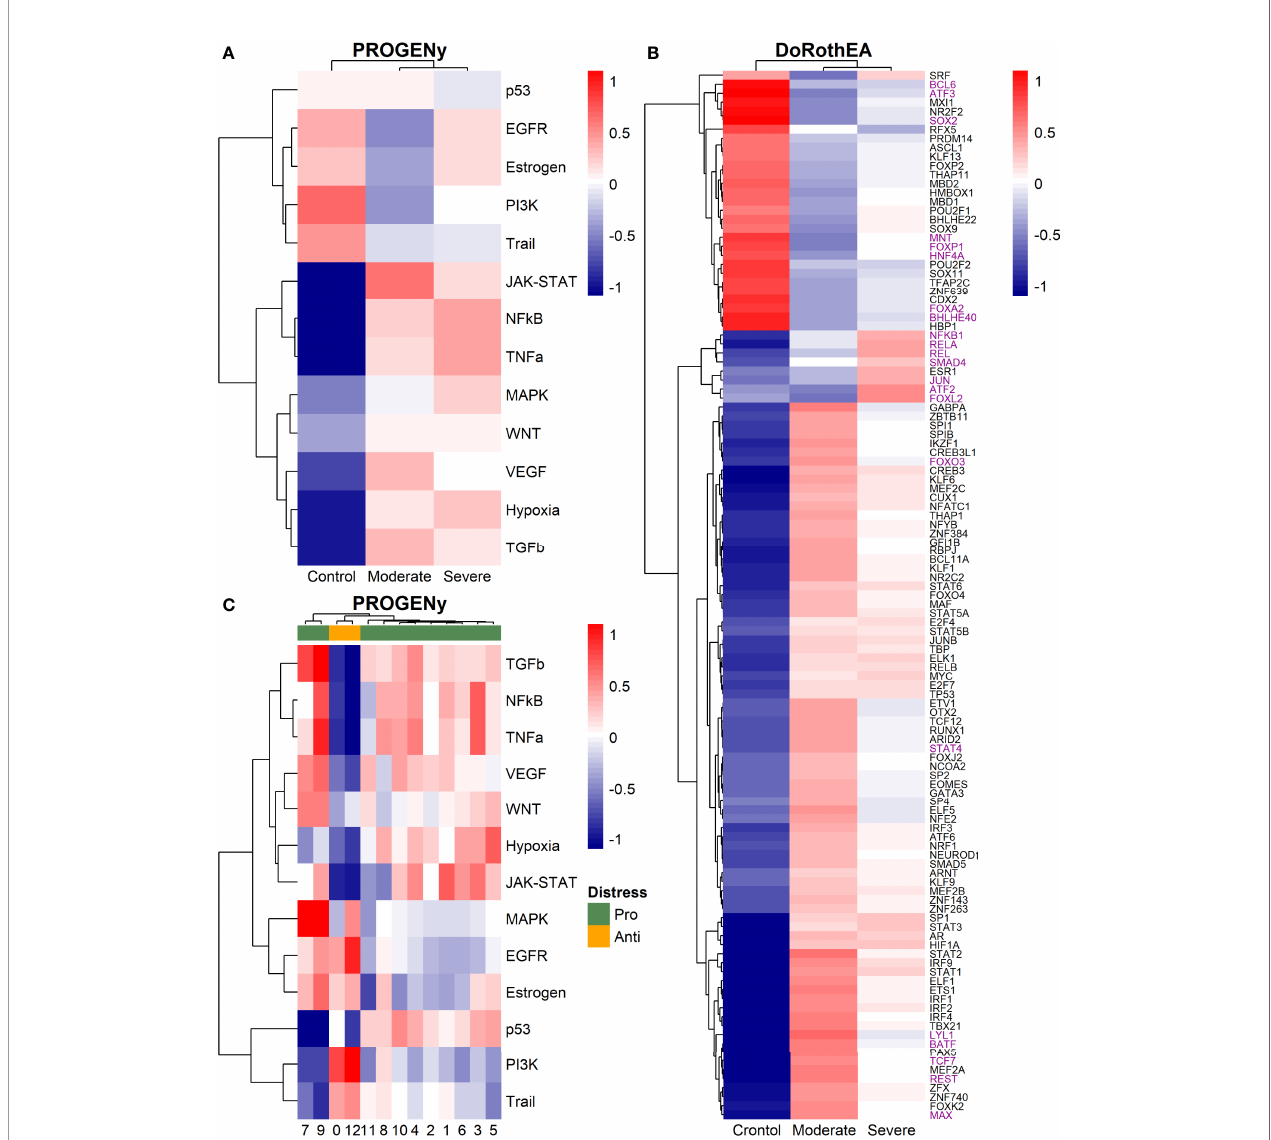
FIGURE 10 | Dysregulated pathways and TFs in T cells. (A) Pathways activations results (PROGENy) according to health status. (B) TF results (DoROthEA) according to health status. Green square highlights those genes only activated on T-NK cells from severe patients. (C) Progeny analysis using mixing data of T and NK cells, green and orange groups are related to a pro and anti-distress response, respectively. Colorbar is related to activation (red) and inactivation (blue)